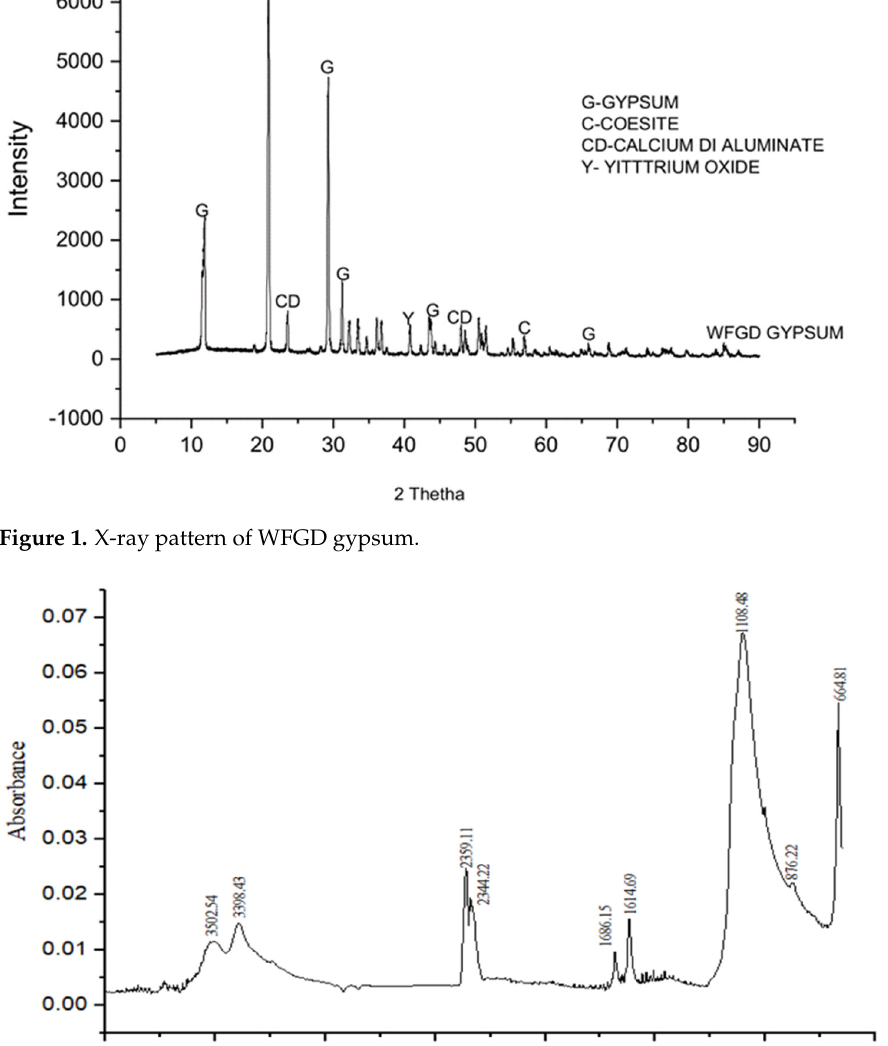
Figure 1. X-ray pattern of WFGD gypsum.